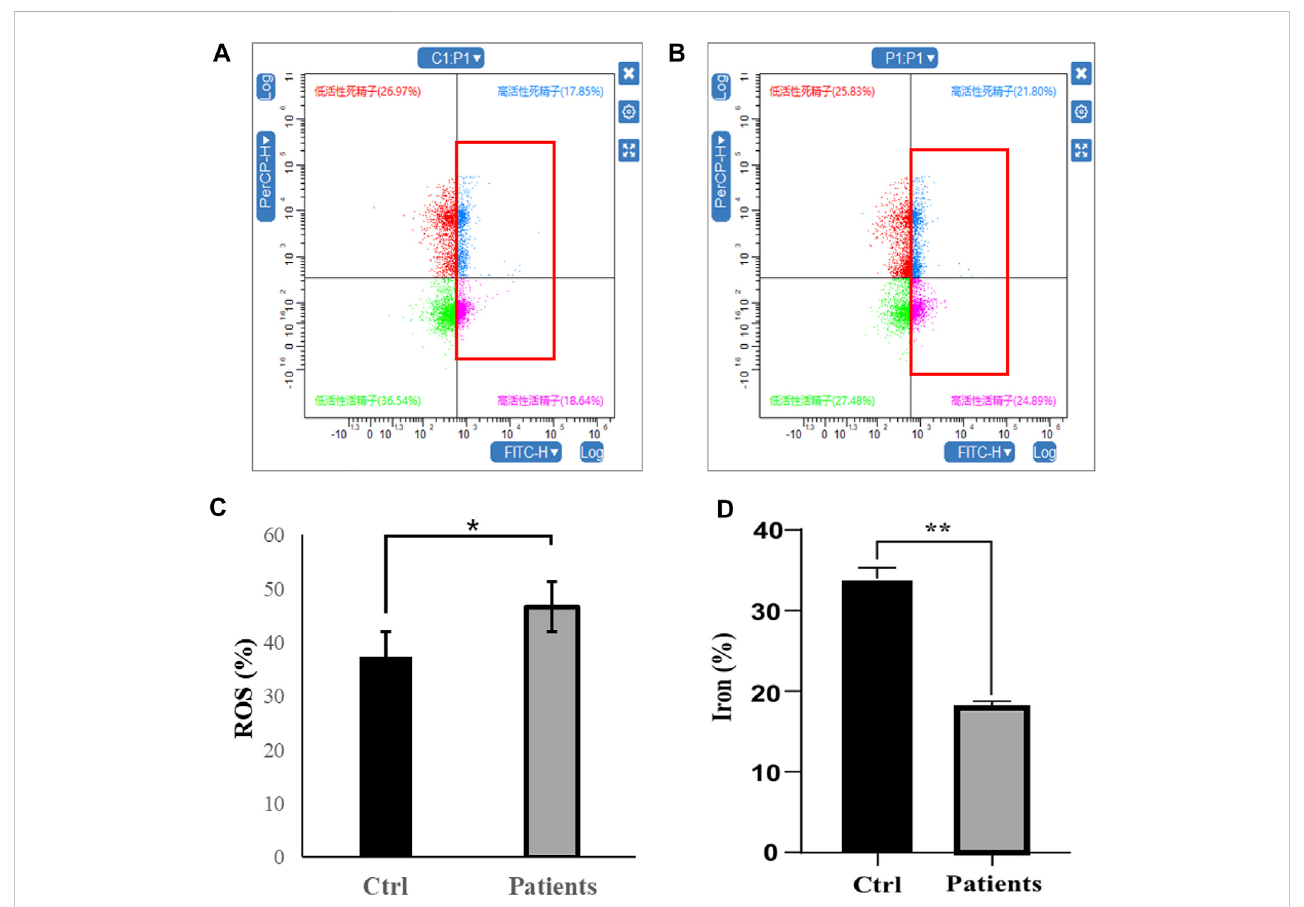
Analysis of reactive oxygen species (ROS) and iron level in human spermatozoa. (A – C) ROS, (D) iron level. All data are displayed as means ± s.e.m. (* p < 0.05, ** p < 0.01; Student ’ s t